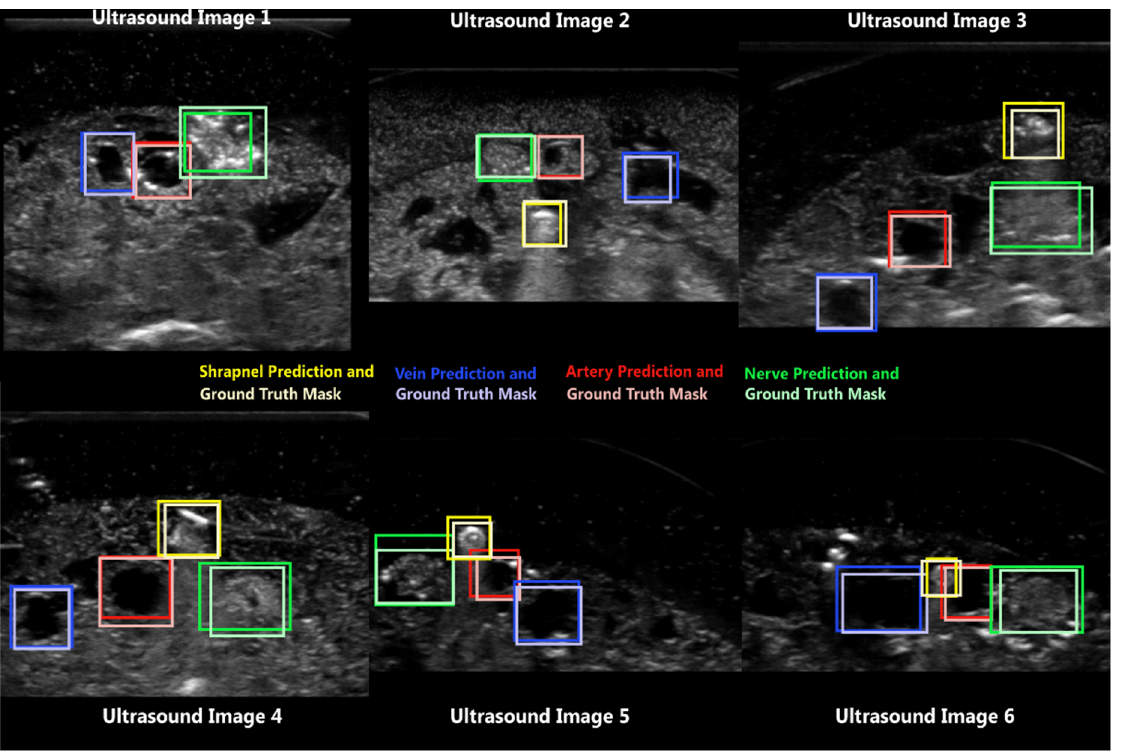
Figure 5. Representative predictions by ShrapOD for modified neurovascular phantoms with and without shrapnel present. Ultrasound Image 1 does not contain shrapnel while the rest have shrapnel present at different distances to the neurovascular features. Shrapnel (yellow), vein (blue), artery (red), and nerve (green) predictions are shown with ground truth overlays shown as fainter, lighter boxes in the same color scheme.